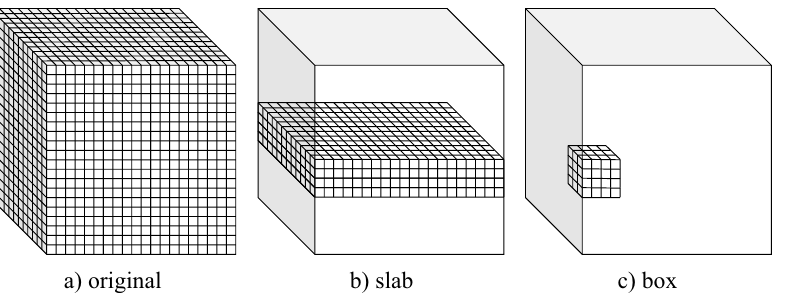
Figure 1. Volumetric setups used for training and testing the considered U-Net-based CNN